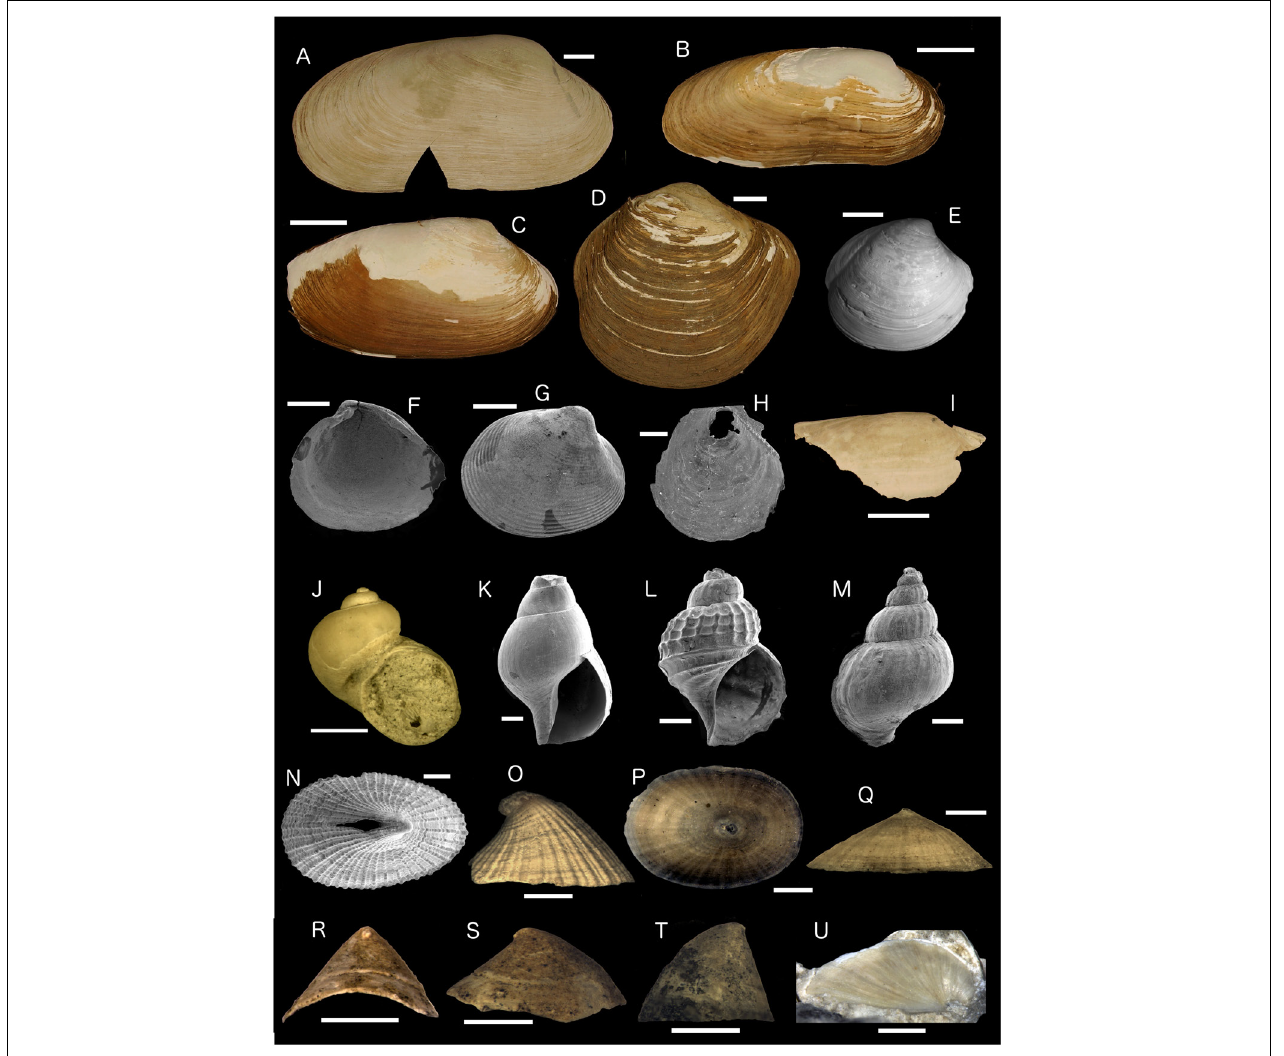
FIGURE 9 | Images of representative bivalves and gastropods from Fossil Hill samples. (A) Phreagena soyoae , right valve external view, DR627 Bio-2 clam scoop, and scale bar is 10 mm. (B) Ectenagena elongata , right valve external view, DR626 A-1, and scale bar is 10 mm. (C) Archivesica packardana , right valve external view, DR626 A-1, and scale bar is 10 mm. (D) Lucinoma aequizonata , right valve external view, DR629 PSC-61, and scale bar is 10 mm. (E) Thyasira flexuosa , right valve external view, DR627 (BB), and scale bar is 5 mm. (F) Axinopsida serricata , right valve internal view, DR627 R-2, SEM, and scale bar is 1 mm. (G) Nucula carlottensis , left valve external view, DR627 R-2, SEM, and scale bar is 1 mm. (H) Delectopecten vancouverensis , right valve external view, DR627 BB, SEM, and scale bar is 0.5 mm. (I) Acharax johnsoni , partial left valve external view, DR627 BIO-2, and scale bar is 10 mm. (J) Depressigyra sp. apertural view, DR476 A-1, and scale bar is 1 mm. (K) Provanna laevis , apertural view, DR476 A-1, SEM, and scale bar is 1 mm. (L) Provanna lomana , apertural view, DR476 A-1, SEM, and scale bar is 1 mm. (M) Provanna sp., adapertural view, DR476 A-1, SEM, and scale bar is 1 mm. (N) Puncturella rothi , apical view, DR627 R-2, SEM, and scale bar is 1 mm. (O) Puncturella rothi , lateral view, DR628 R-3, and scale bar is 2 mm. (P,Q) Paralepetopsis sp., apical (P) and lateral (Q) views, DR627 R-2, and scale bars are 1 mm. (R,S) Pyropelta “low-spired,” anterior (R) and lateral (S) views, DR627 R-2, and scale bars are 1 mm. (T) Pyropelta corymba , lateral view, DR627 R-2, and scale bar is 1 mm. (U) Lepetodrilus sp., lateral view, DR629 R-2, and scale bar is 2